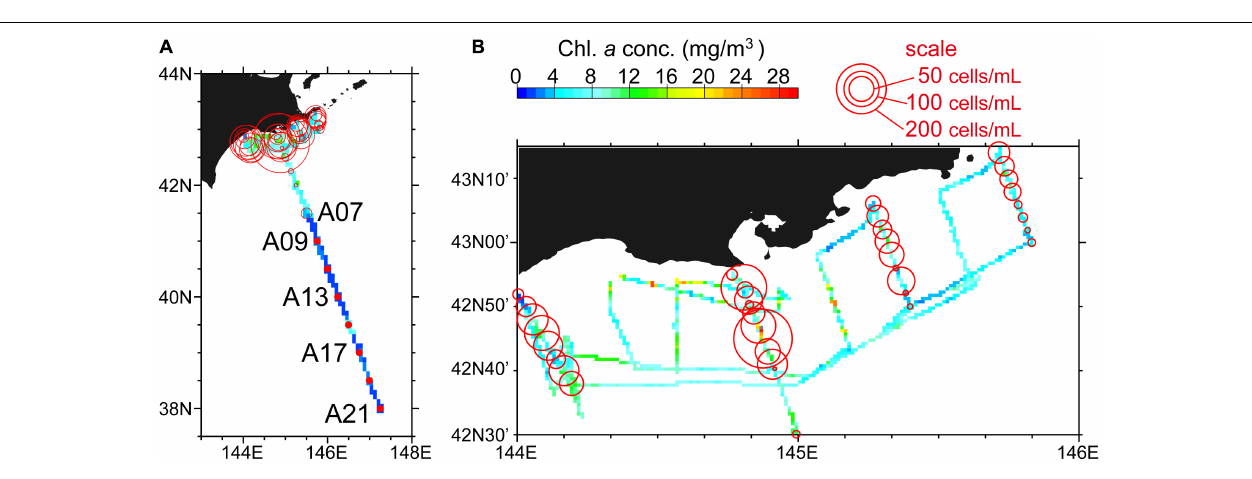
Frontiers in Marine Science |